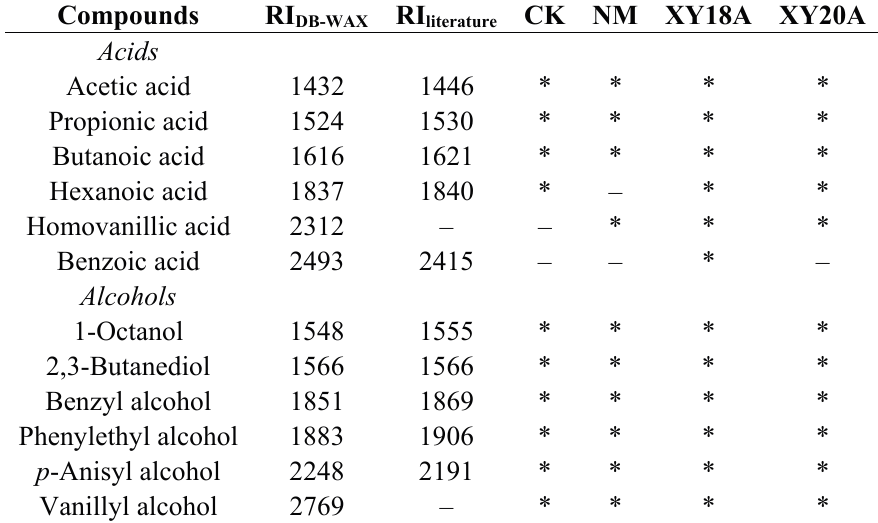
Table 1. Volatile compounds detected in the headspace from cured vanilla beans obtained using various curing